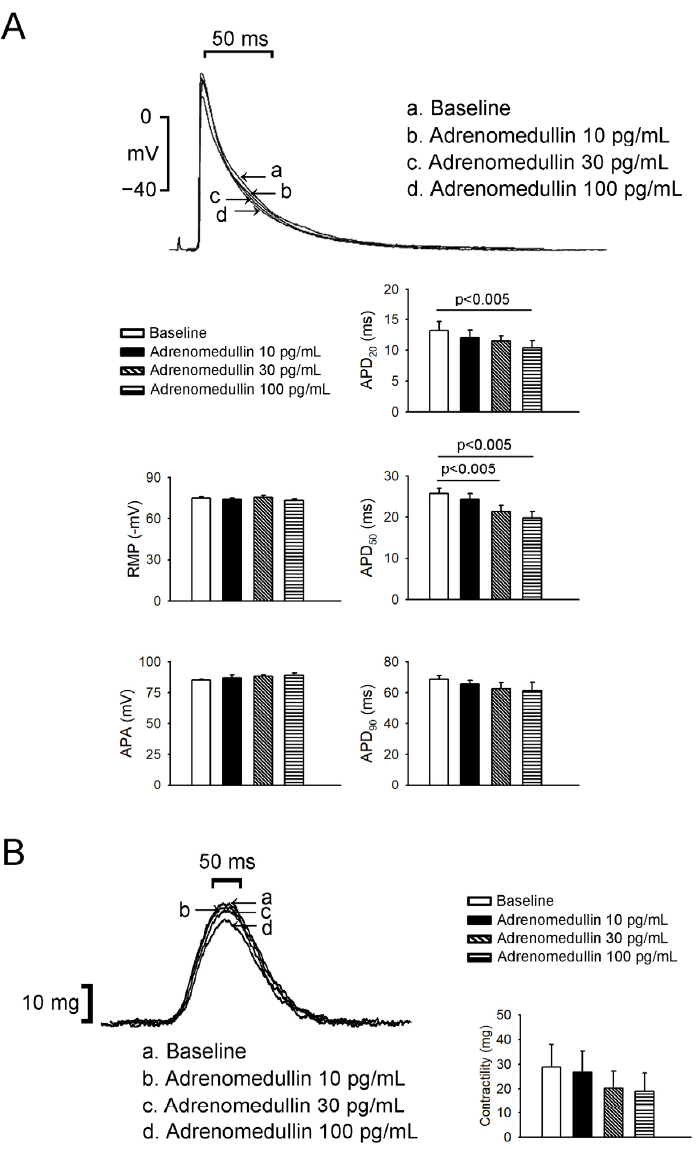
Figure 4. Effects of adrenomedullin on left atrium (LA) AP morphology and contractility. ( A ) The su- perimposed traces illustrate the effects of adrenomedullin on LA APs. Adrenomedullin (10–100 pg/mL) did not change APA, resting membrane potential, or APD90 in LA tissue ( n = 7). Adrenomedullin at 30 and 100 pg/mL (but not 10 pg/mL) reduced LA AP duration at 20% and 50% repolarization. ( B ) Adrenomedullin did not reduce LA contractility.